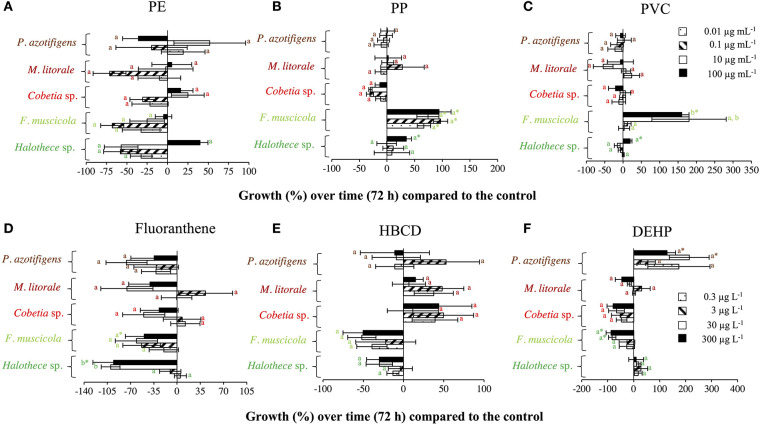
Growth responses of diazotrophs subject to MPs and organic additives under relevant concentrations in the marine environment after 72 h, compared with the control value. (A) PE, (B) PP, and (C) PVC, with 0, 0.01, 0.1, 10, and 100 μg mL−1. (D) Fluoranthene, (E) HBCD, and (F) DEHP, with 0, 0.3, 3, 30, and 300 μg L−1. Values are the mean, and the error bar is the standard error between the replicates (n = 3). Letters indicate pairwise analysis among the variables (i.e., concentration) inside each strain (see the different colors), and asterisks (*) indicate pairwise significant differences between variables and the control (p < 0.05), using a post-hoc test (Wilcoxon) after Kruskal-Wallis over the whole dataset.